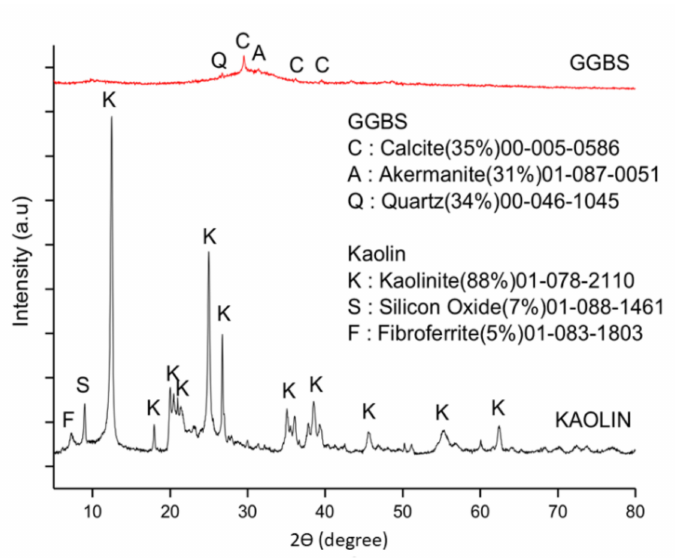
Figure 2. Quantitative analysis of phase composition of kaolin and GGBS.